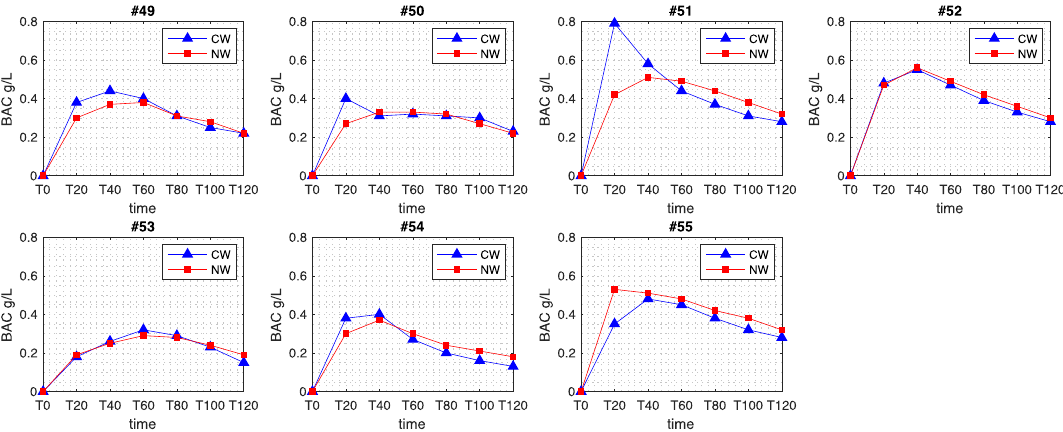
Figure A5. Concentration–time curves of BAC responses to natural wine and conventional wine for subjects #49 – #55.